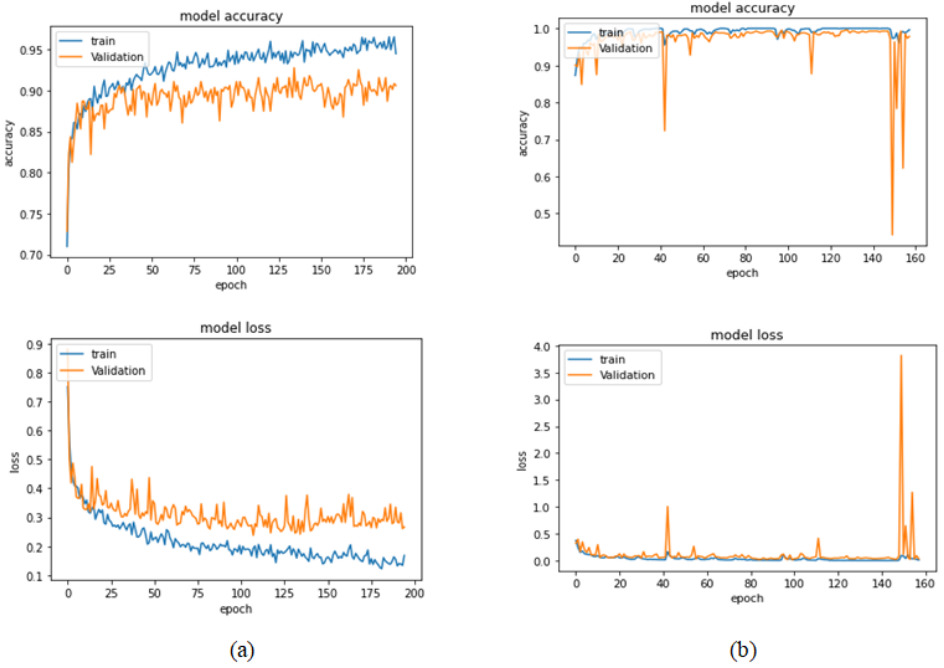
Figure 15. Learning curves for Xception at 0.0001 learning rate in 100× magnification-dependent binary classification. ( a ) Accuracy and loss curves of Phase 1 of training. ( b ) Accuracy and loss curves of Phase 2 of training.